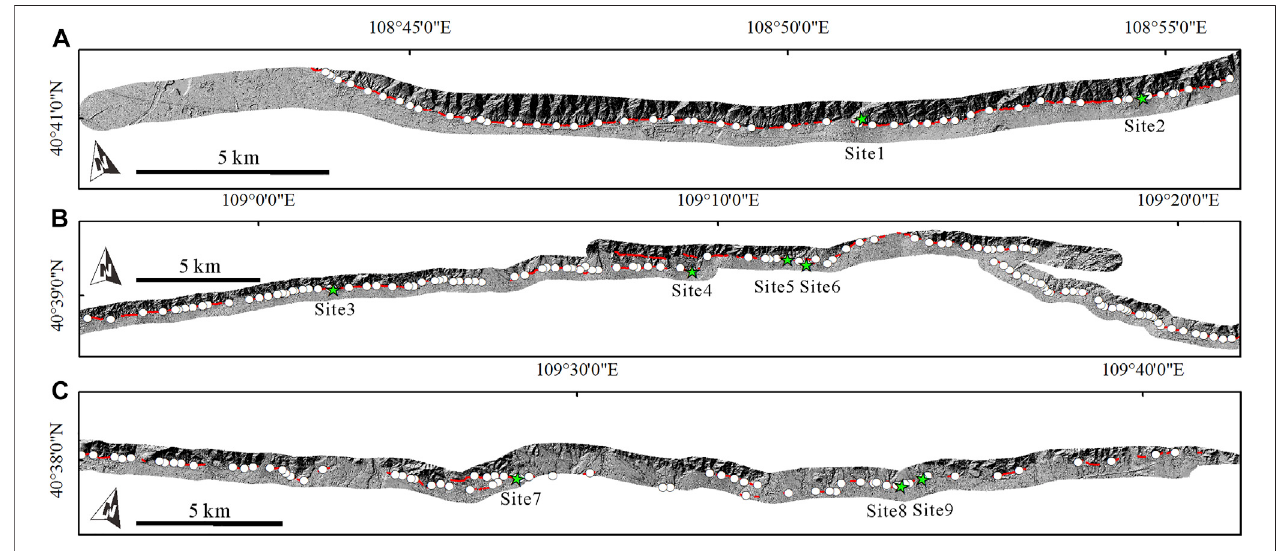
FIGURE 2 | (A) , (B) , and (C) show the LiDAR topography of the Xishanzui-Gongmiaozi segment, the Gongmiaozi-Heshunzhuang segment, and the Heshunzhuang-Baotou segment of the Wulashan Piedmont Fault, respectively. The red lines denote the mapped fault traces. The white circles mark the locations of all vertical displacement measurements, and the green stars indicate the selected nine study sites where fault scarps have been well preserved.